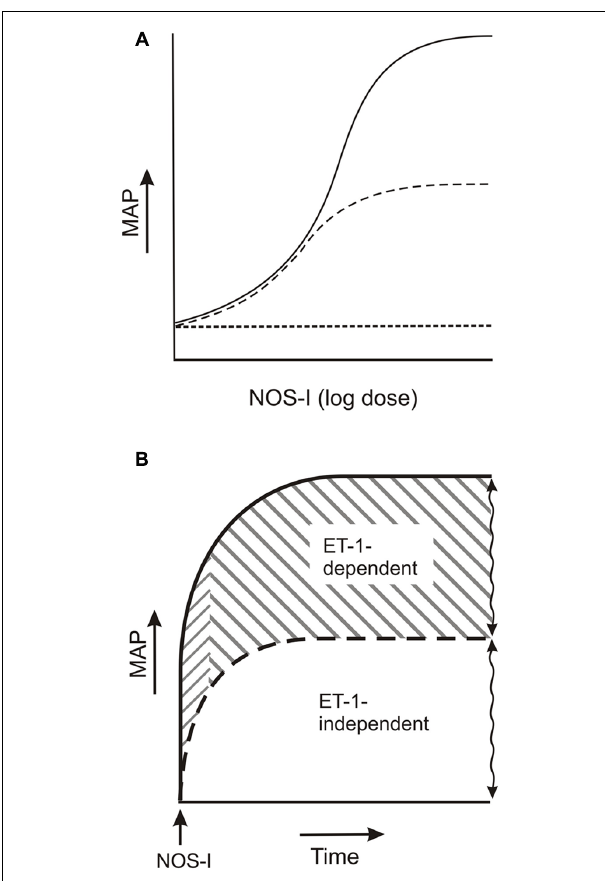
FIGURE 2 | ET-1-dependent and -independent components of the elevated arterial pressure due to acute NOS inhibitor. (A) Dose- response: NOS inhibitor (NOS-I) dose and ET-1-independent (dashed line) and -dependent pressure elevation (solid line). (B) ET-1 pools: ET-1-dependent component (solid line) consists of an initial rapid and a subsequent plateau increase in pressure (rightward upward and rightward downward slanted lines, respectively), which reflect dependencies on stored ET-1 and de novo synthesized ET-1 pools, respectively. ET-1-independent pressure elevation is indicated by the dashed line. Squiggled vertical lines indicate varied magnitudes of ET-1-independent and -dependent components of pressure elevation. See text for further